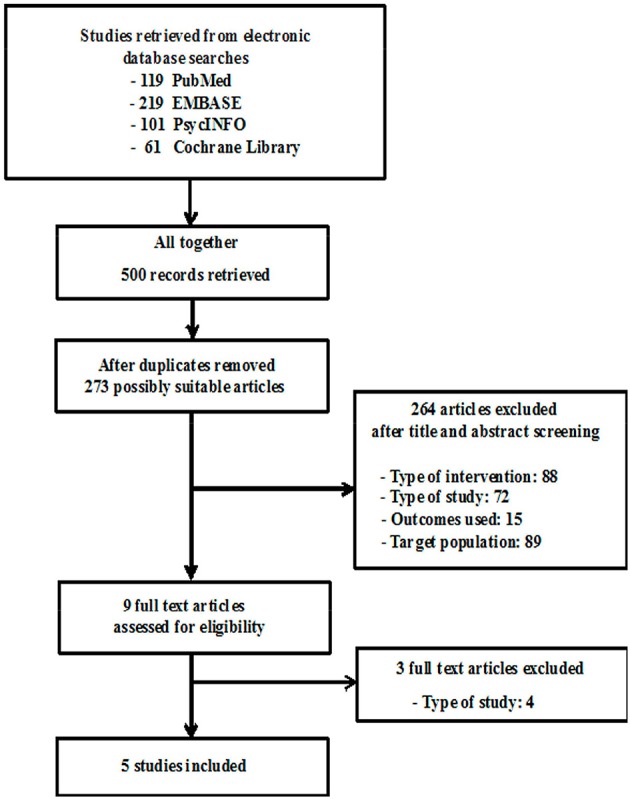
Algorithm of study selection.